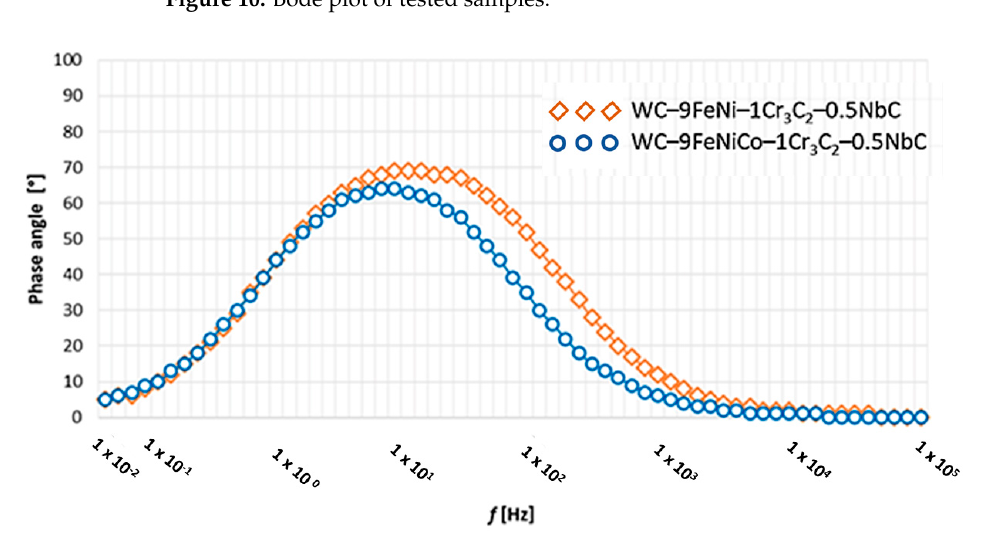
Figure 11. Nyquist plot of tested samples.